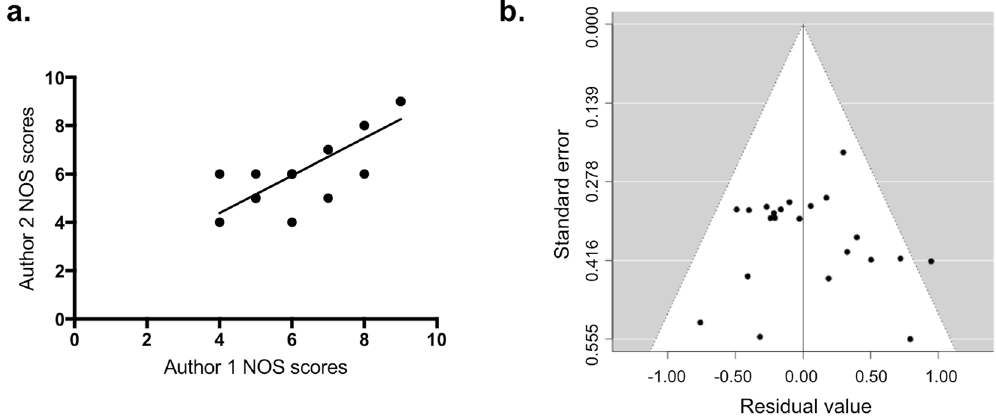
Figure 2. Distribution of studies used in the meta-analysis by ( a ) study quality, as assessed on the NOS by two independent raters with high correlation ( r (20) = 0.81, p < 0.00001), and by ( b ) funnel plot, to diagnose publication